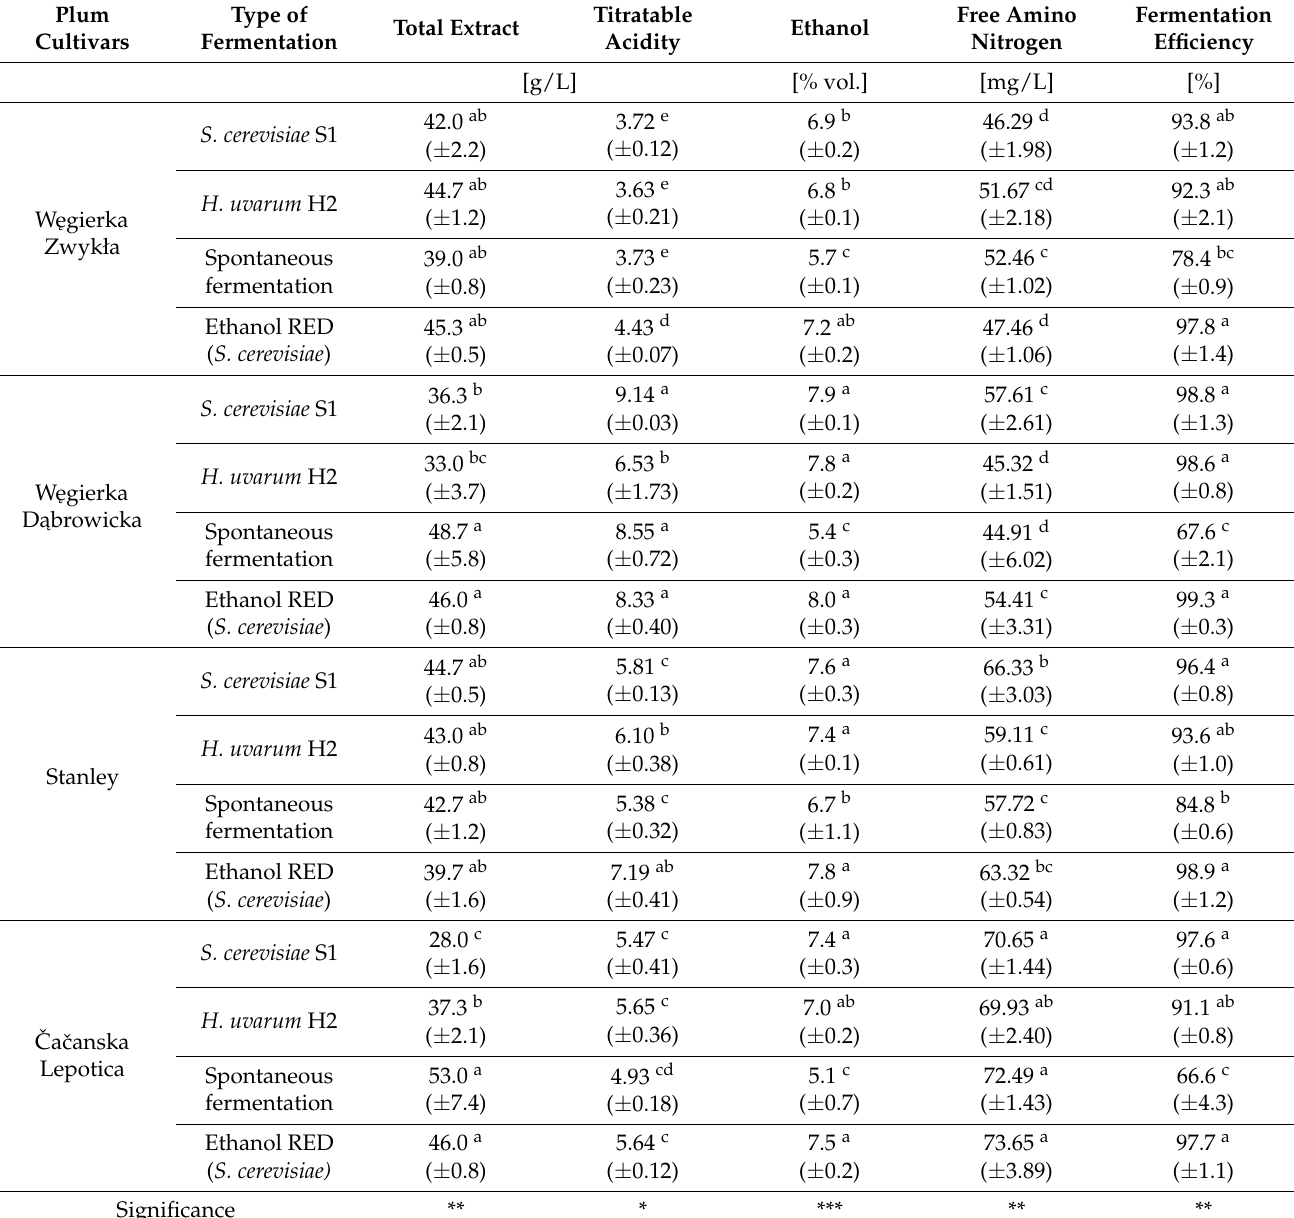
Table 2. Chemical composition of plum jerkums fermented spontaneously or with different yeast starter cultures. Plum Cultivars